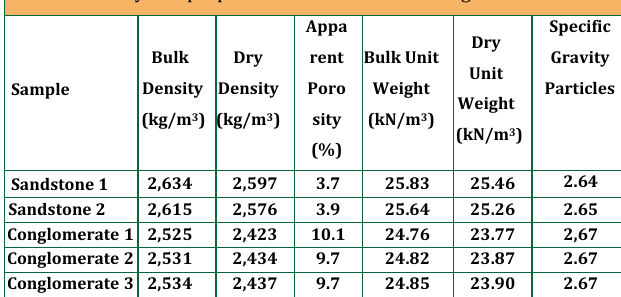
Table 1: Physical properties of sandstone and conglomerate cores